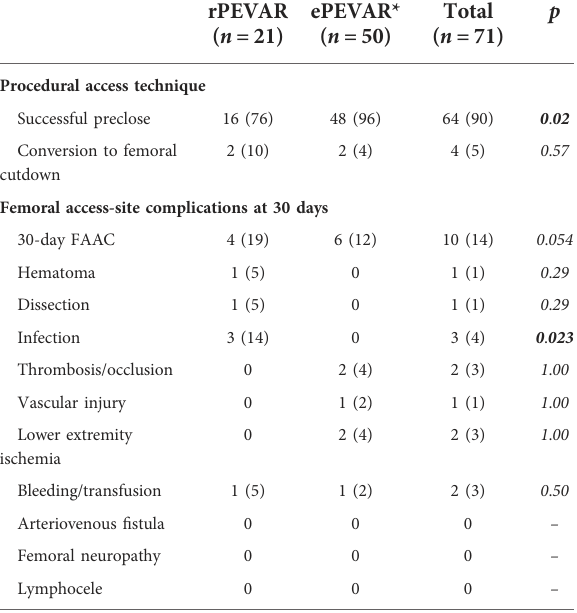
TABLE 3 Femoral access-site techniques and